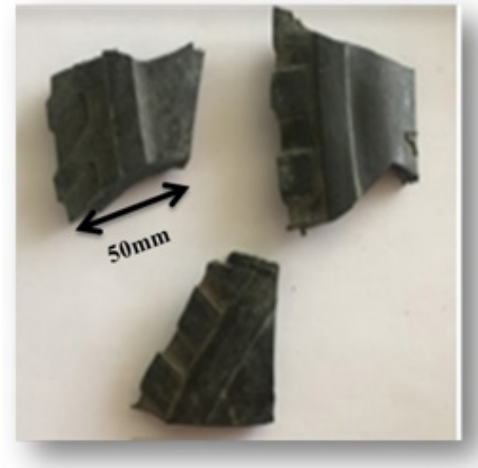
Figure 2. Visual aspect of tire shreds of 50 mm.